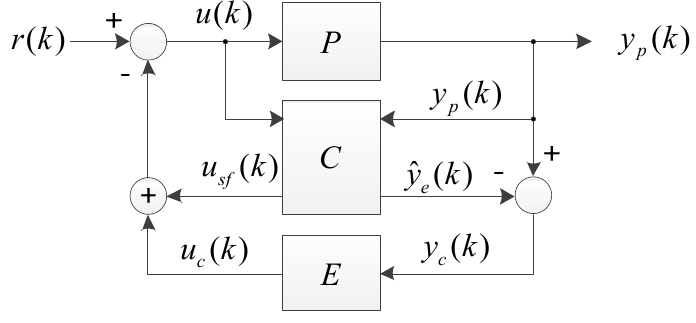
Figure 5. Proposed control structure.